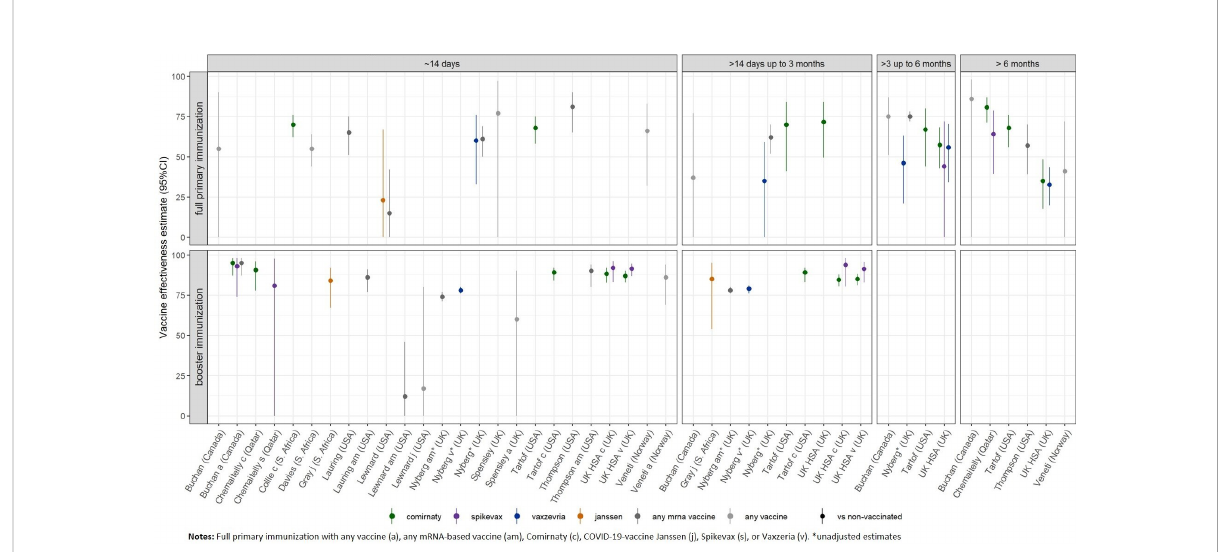
FIGURE 6 Vaccine effectiveness estimates against severe COVID-19 (incl. hospitalization, ICU admission or death) due to SARS-CoV-2 infection of the Omicron variant after full primary immunization and booster dose, as reported in the study for the de fi ned time strata after immunization. For booster immunization the COVID-19 vaccine used for primary immunization is